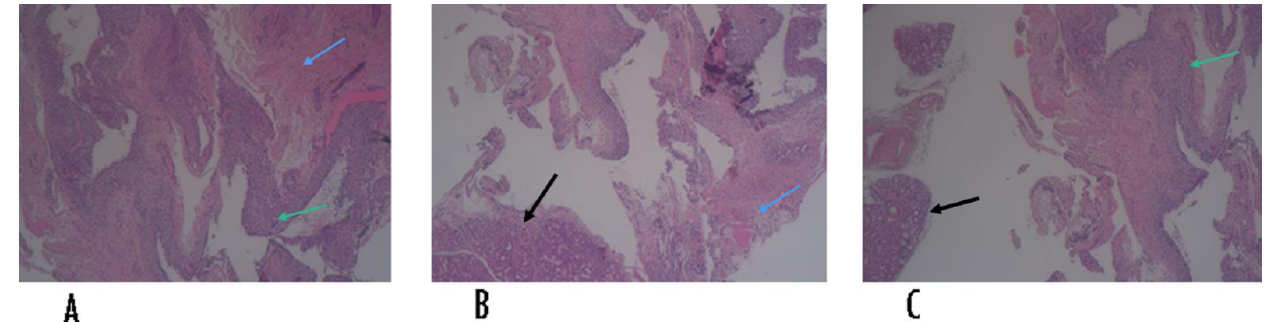
Figure 4. Twelve months follow up. The patient showed the labial mucosa of conformation and normal color, without any scars.